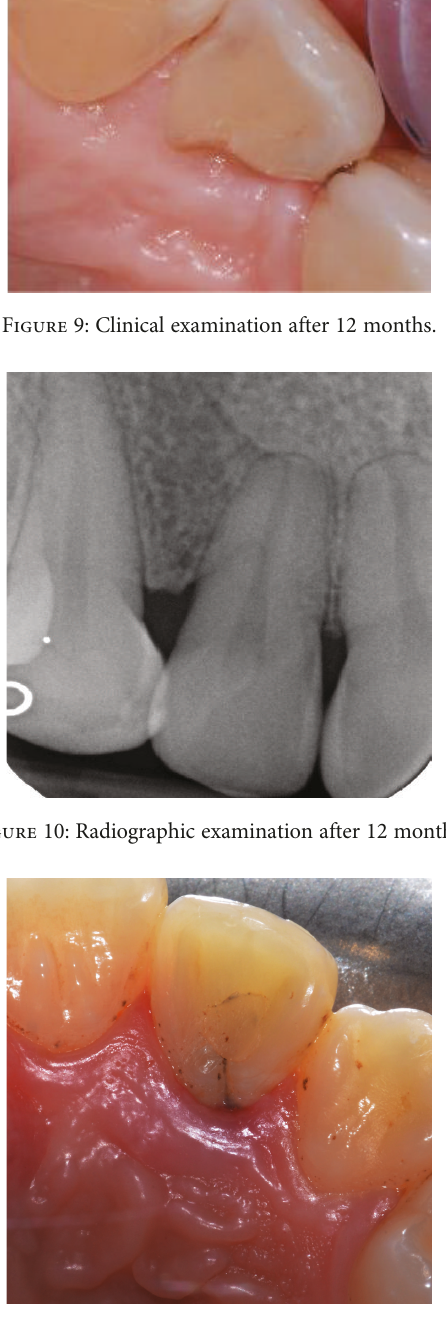
Figure 11: Clinical examination: a 10 mm periodontal pocket is associated with 1.2 in correspondence of a palatal groove.